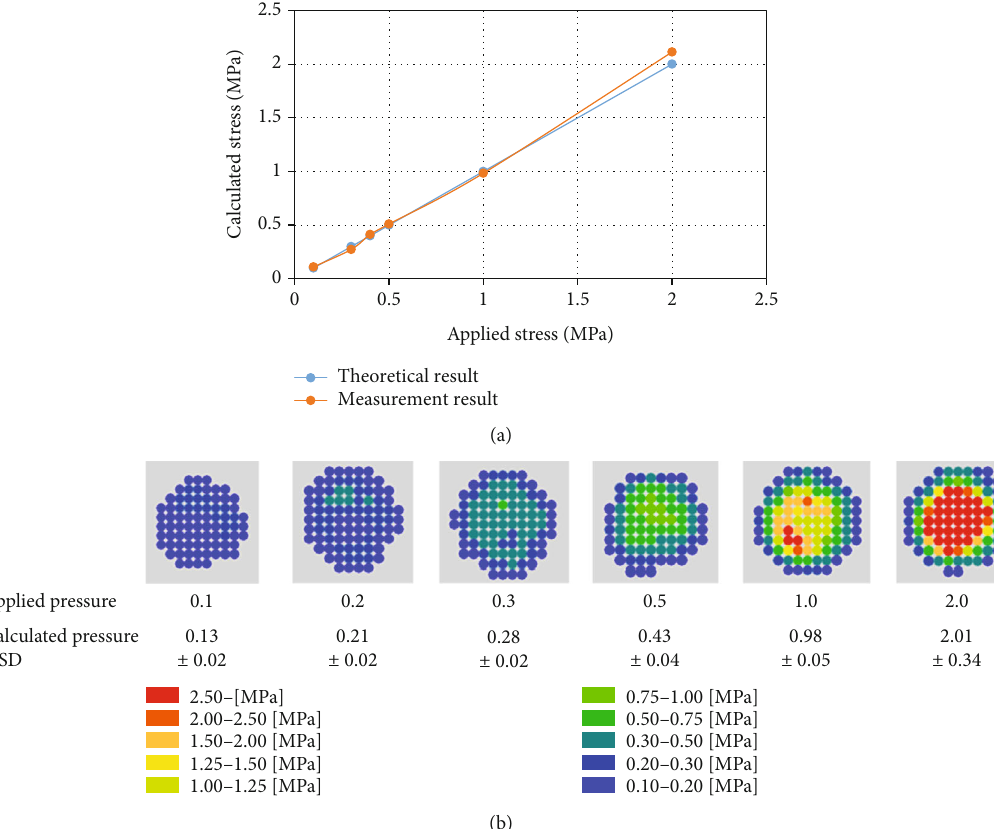
Figure 4: Reliability of the sensor: (a) relationship between applied pressure and calculated pressure and (b) color map of pressure